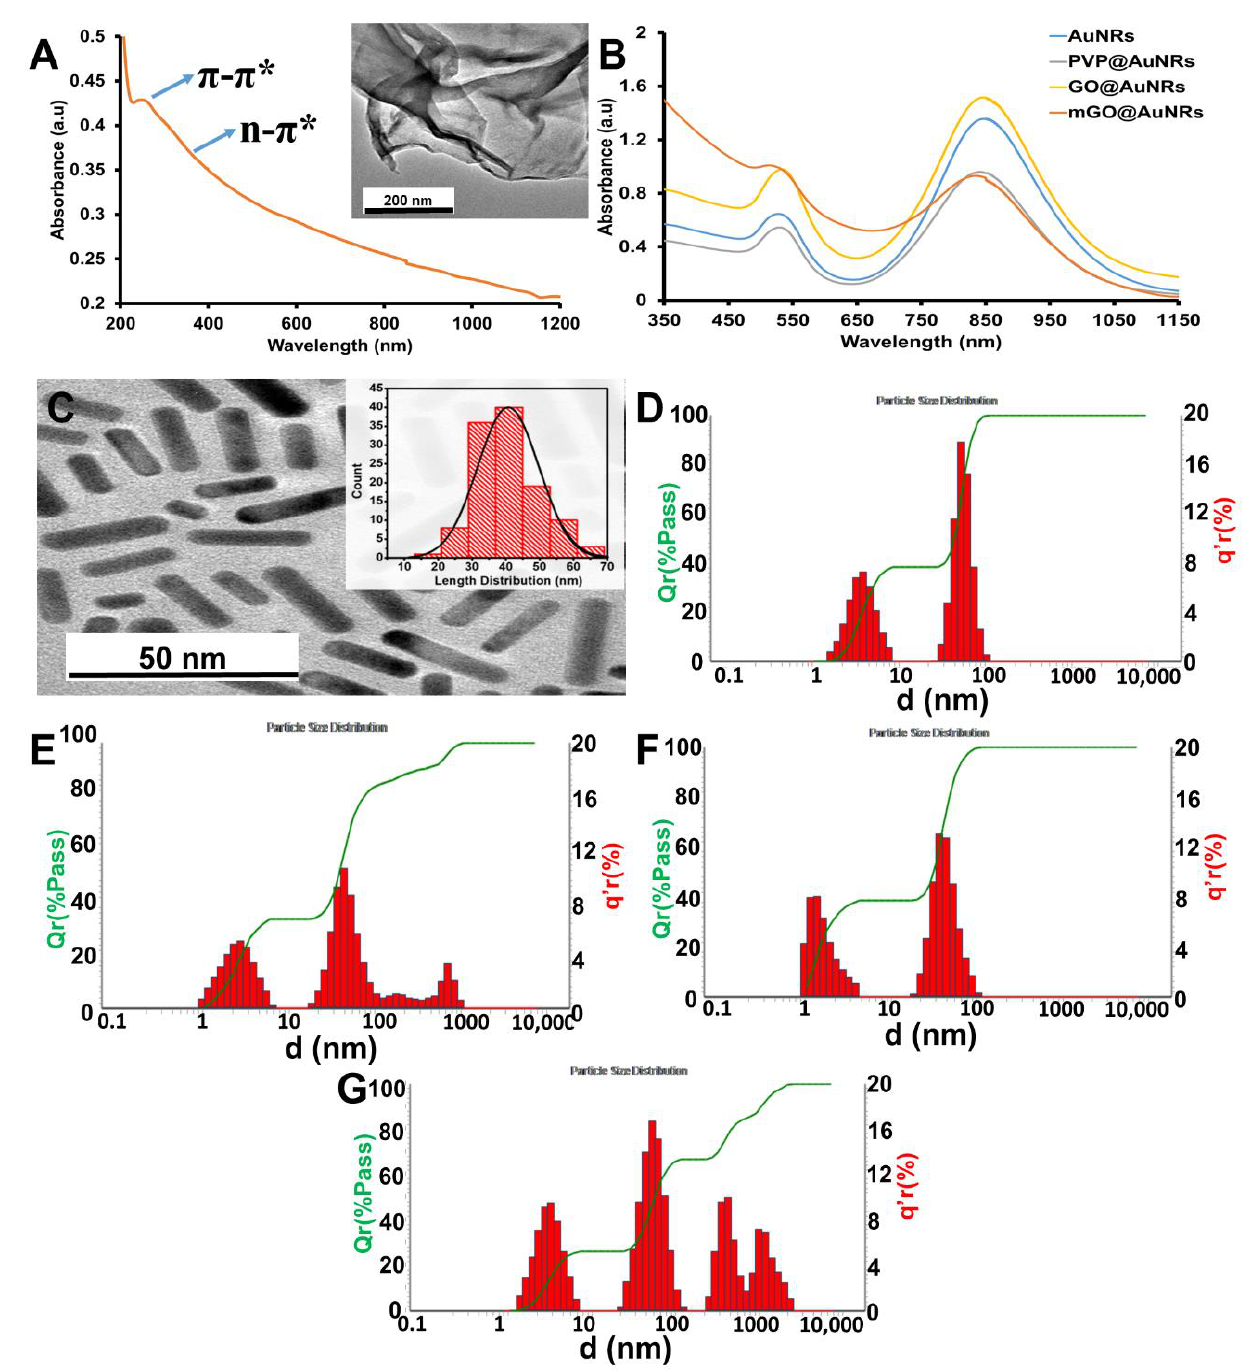
Figure 1. UV-Vis-NIR spectra of ( A ) GO (Inset: GO TEM image scale 200 nm) and ( B ) UV-Vis-NIR spectrum of AuNRs, PVP@AuNRs, GO@AuNRs, and mGO@AuNRs. ( C ) TEM image of AuNRs (inset: Size distribution, TEM image scale 100 nm). Hydrodynamic size distribution of ( D ) AuNRs, ( E ) GO@AuNRs, ( F ) PVP@AuNRs, and ( G ) mGO@AuNRs.